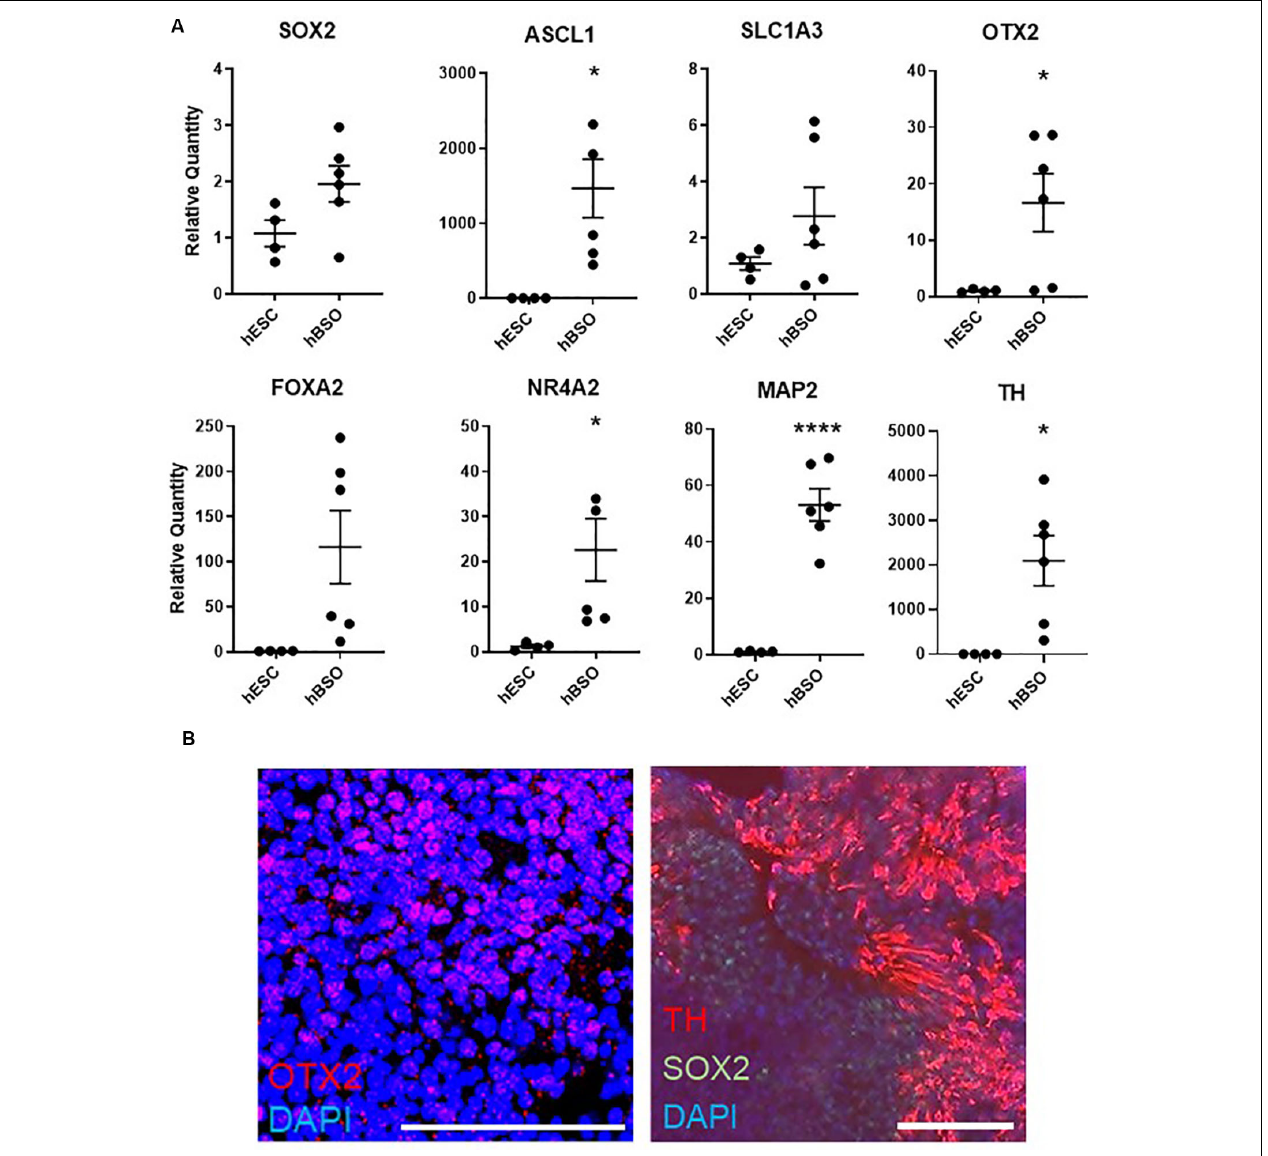
FIGURE 2 | Quantitative PCR and immunohistochemical analysis of 1-month-old hBSOs from hESCs. (A) Quantitative PCR analysis of 1-month-old hBSOs for the markers of neural stem/progenitor cell (SOX2, Mash1, SLC1A3), mature neuron (MAP2), midbrain (OTX2), and mDA (FOXA2, NR4A2, TH). Error bars indicate mean ± SEM; * p = 0.0167 (ASCL1), * p = 0.0412 (OTX2), * p = 0.0387 (NR4A2), **** p < 0.0001 (MAP2), * p = 0.0178 (TH). (B) Immunohistochemical staining of midbrain marker (OTX2), mDA marker (TH), and neural stem cell marker (SOX2) at 1 month. Bars = 100 µ